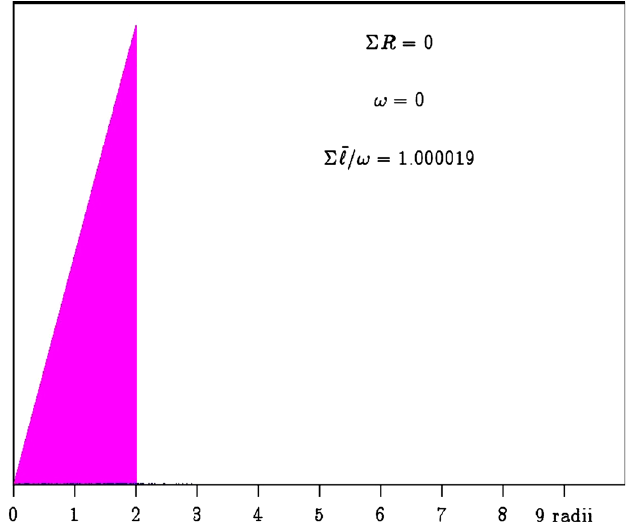
Fig. 1. Distribution of the lengths travelled by the particles for an empty sphere.